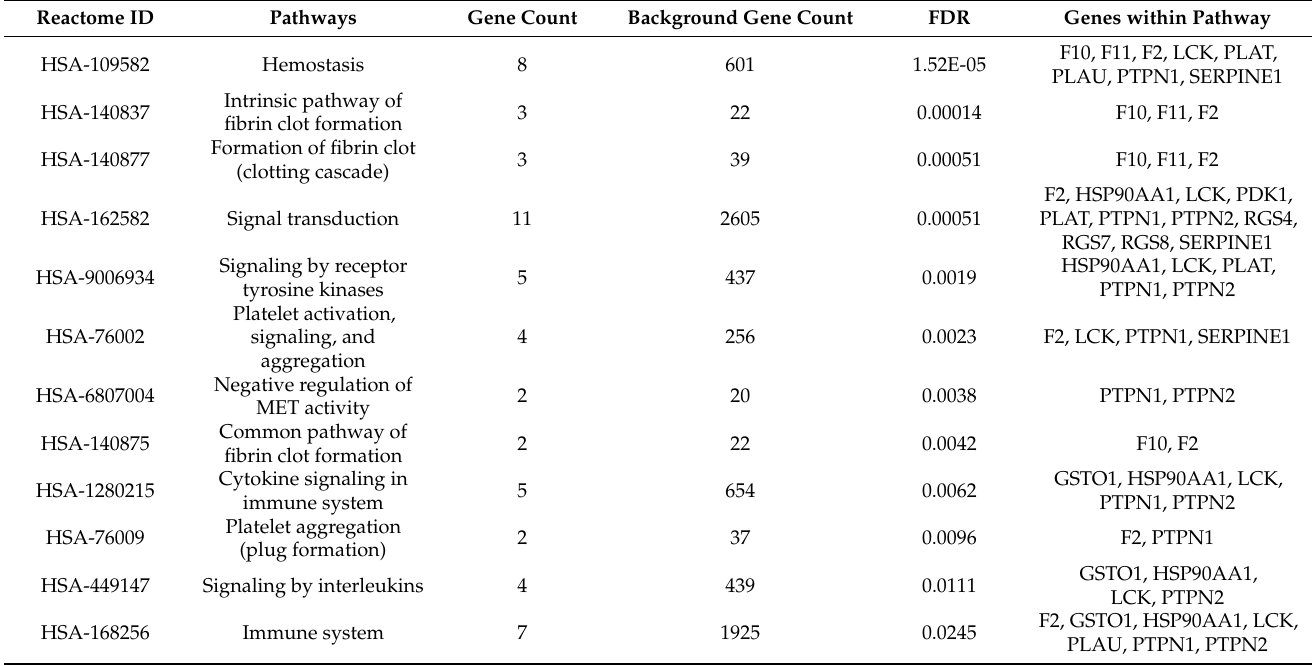
Table 2. Pathways modulated by the